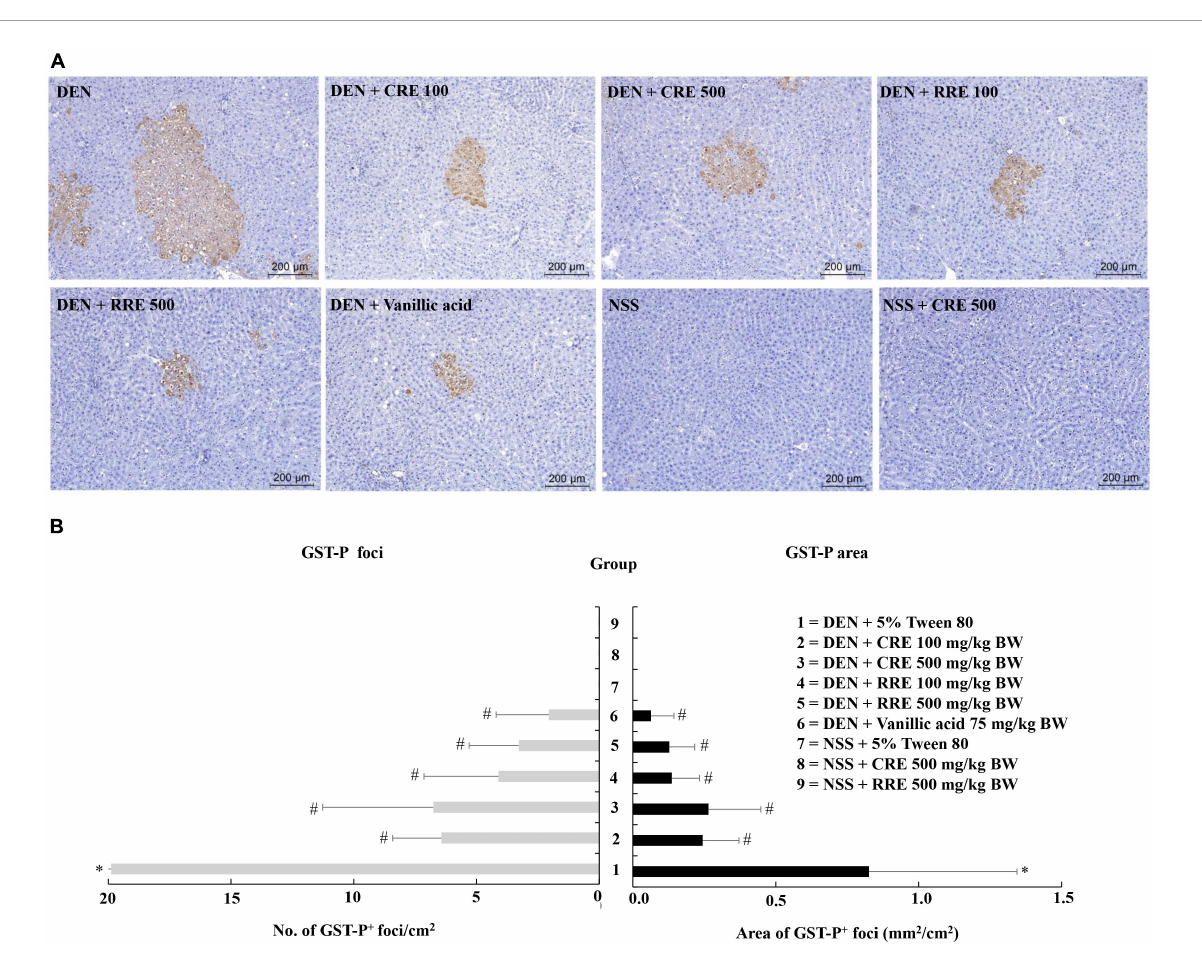
FIGURE3 Effect of cooked glutinous purple rice extracts on hepatic GST-P positive foci formation in rats. (A) GST-P-positive foci in liver tissue, (B) number and area of GST-P-positive foci in rats. DEN, diethylnitrosamine; CRE, cooked glutinous purple rice extract; RRE, raw glutinous purple rice extract; BW, body weight. Values are expressed as mean ± SD. ∗ Significantly different from the negative control group (group 7), p < 0.05. # Significantly different from the positive control group (group 1), p <